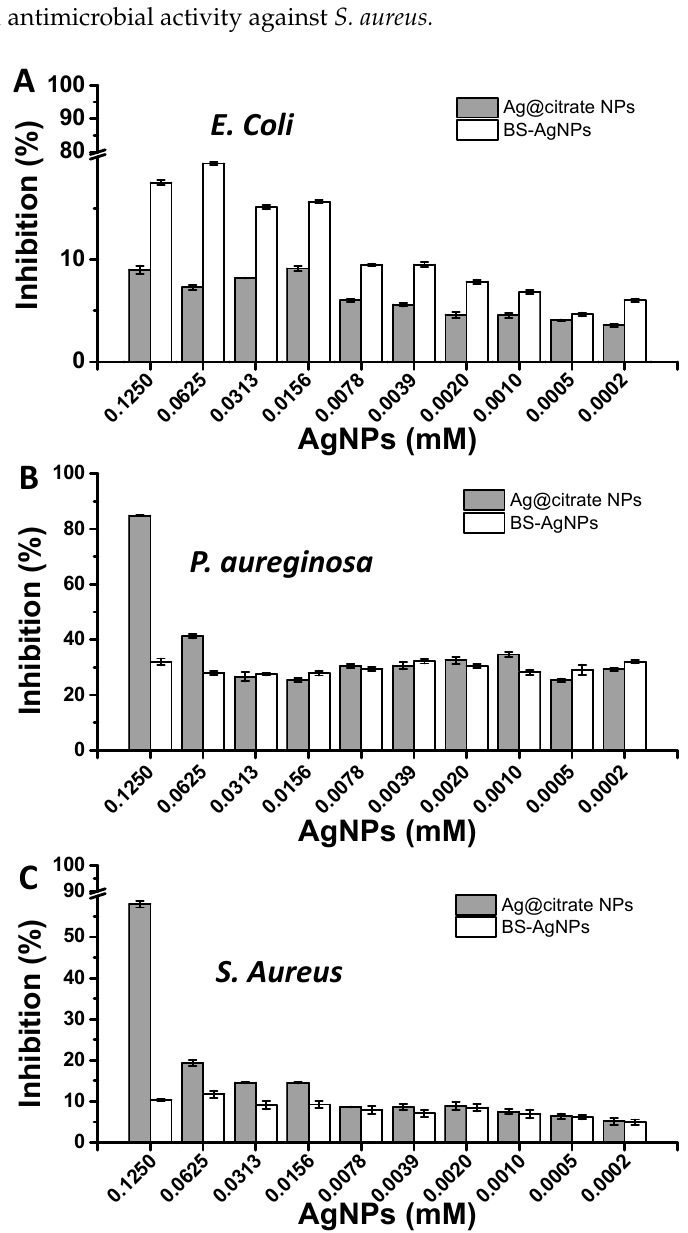
Figure 5. Inhibition percentages obtained with Ag@citrate NPs and BS-Ag NPs against ( A ) E. coli ( B ) P. aeruginosa and ( C ) S. aureus at different concentrations after 24 h. Results are averages of triplicate experiments.